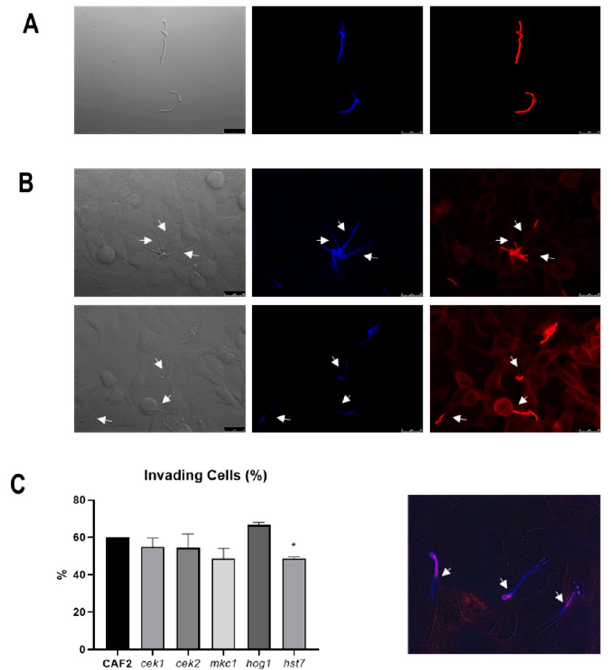
Figure 2. Epithelial invasion assay by C. albicans strains. ( A ) Staining control of C. albicans cells without epithelia treated with calcofluor white (seen in blue) and Alexa Fluor 488 conjugate of succinylated concanavalin A, in red. ( B ) Representative fluorescence microscopic images of C. albicans invading epithelial cells. The white arrows indicate the point where hyphae breach the epithelium and Con A staining disappears (better appreciated in the merged image shown in the lower panel). Bars indicate 25 µ m. ( C ) Quantification of C. albicans cells invading the epithelium. Percentages are related to the starting amount of cells and error bars represent the standard deviation of the mean from three independent experiments. At least 100 fungal cells were analysed on each experiment. * p <